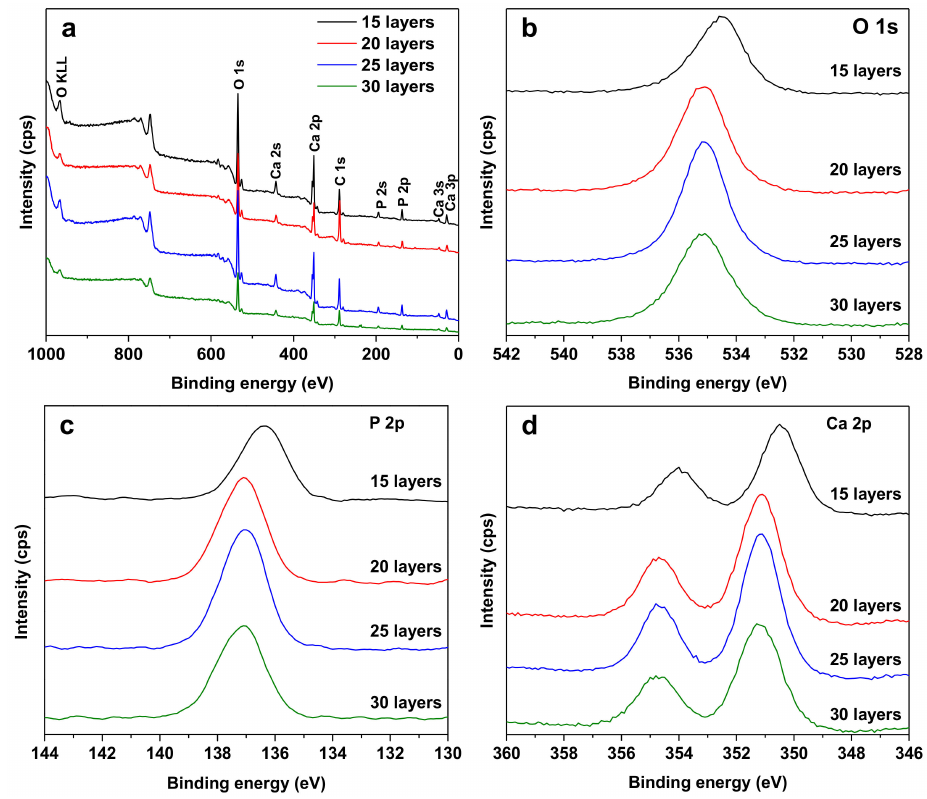
Figure 6. XPS survey spectra ( a ) and high-resolution O 1 s ( b ), P 2 p ( c ) and Ca 2 p ( d ) XPS spectra taken from the surface of deposited and annealed CHA films with di ff erent numbers of layers. The SEM micrographs of the surfaces of obtained CHA samples are shown in Figure